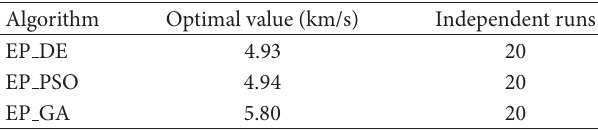
Table 9: The best results using improved heuristic algorithm.